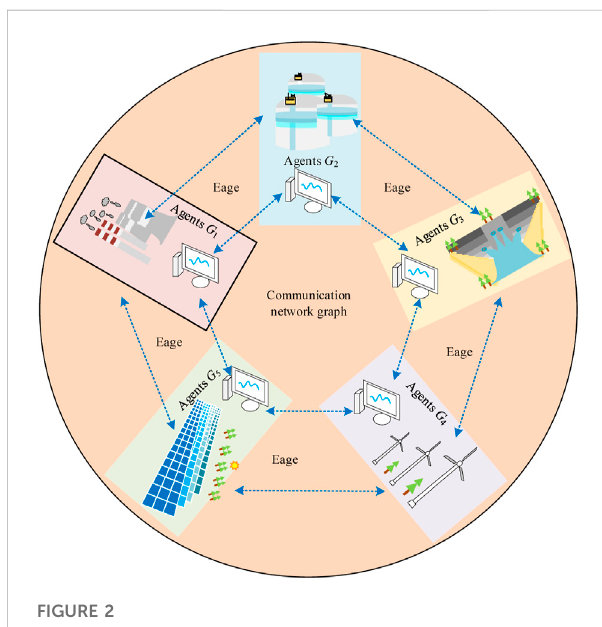
FIGURE 2 DT-DPT communication